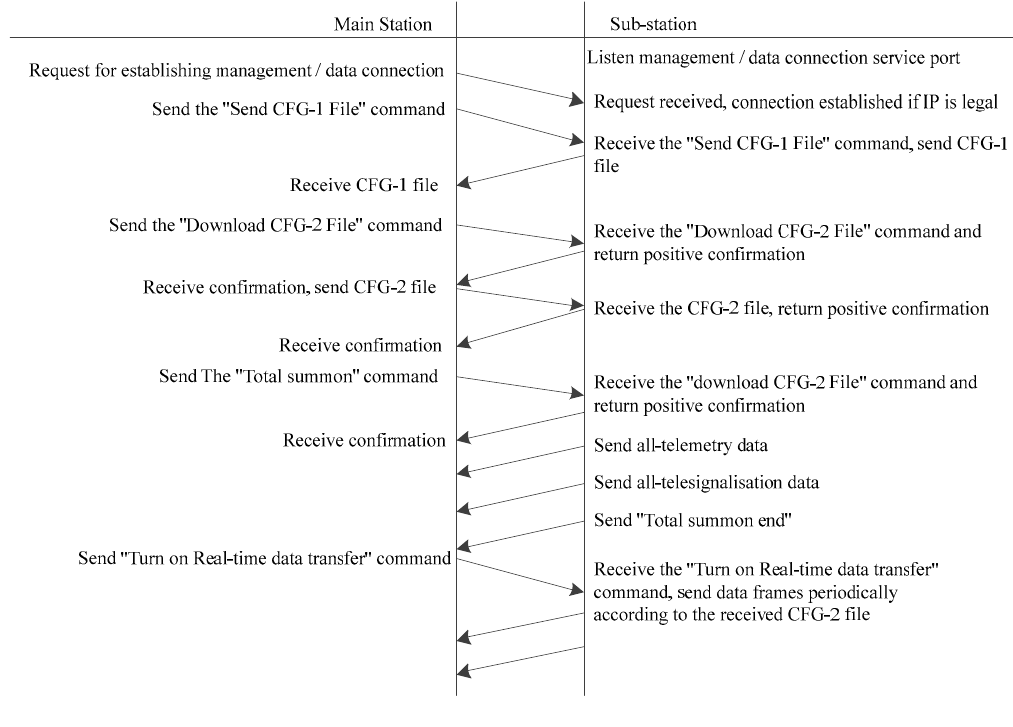
Figure 5. Communication startup process.